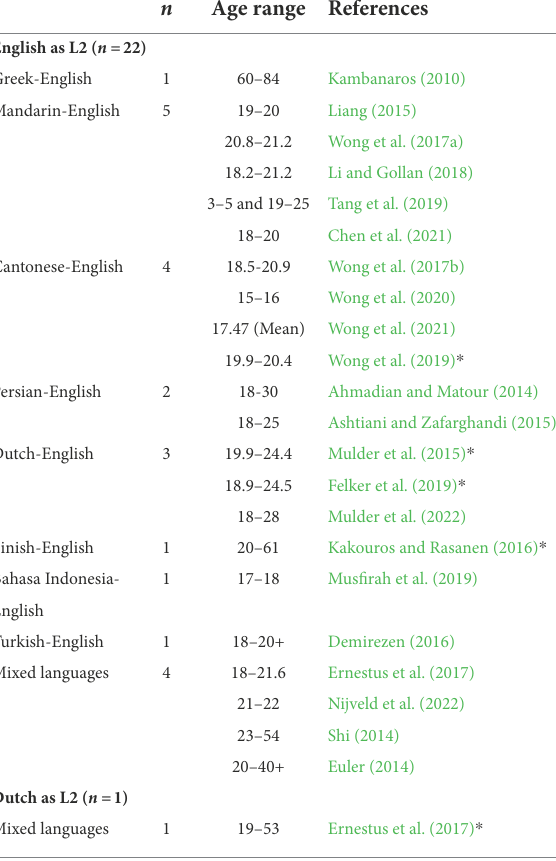
TABLE 3 Studies of non-native sample’s connected speech processing.